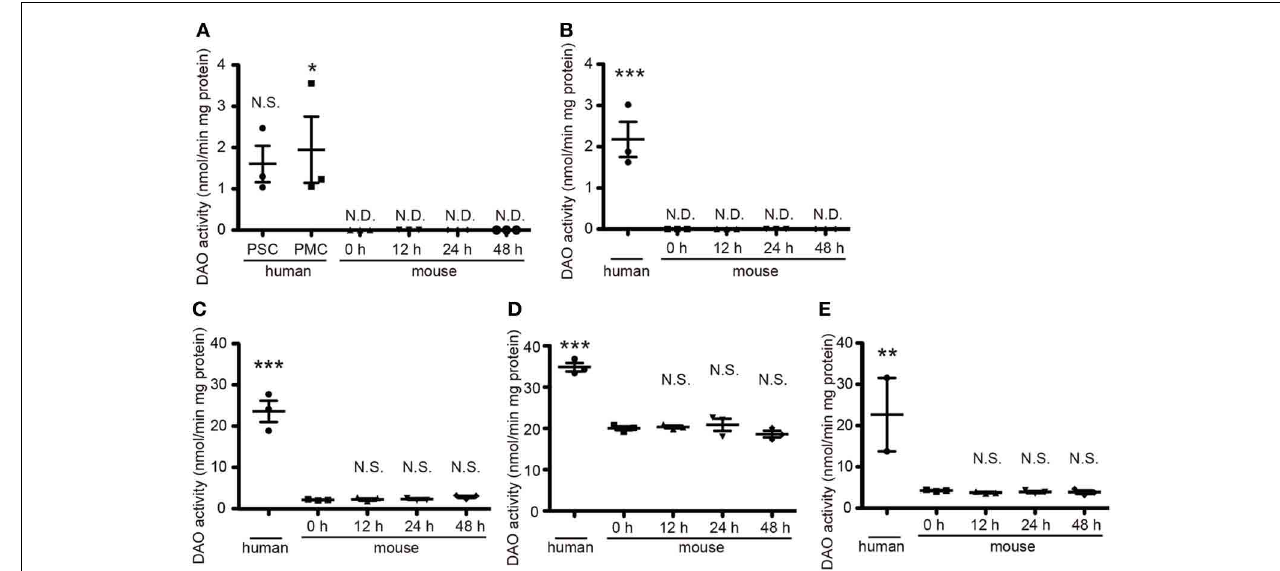
FIGURE 1 | Quantitative DAO activity in human and mouse tissue. Tissue DAO activities in human and mouse CNS were measured. Mouse tissues were dissected at indicated hours after the death. (A) PSC and PMC of human cerebral cortex ( n = 3, each), and whole mouse cerebral cortex ( n = 3, each). (B) Posterior limb of human internal capsule ( n = 3) and mouse striatum ( n = 3, each). (C) Ventral part of human pons ( n = 3) and mouse brainstem ( n = 3, each). (D) Posterior lobe in hemisphere of human